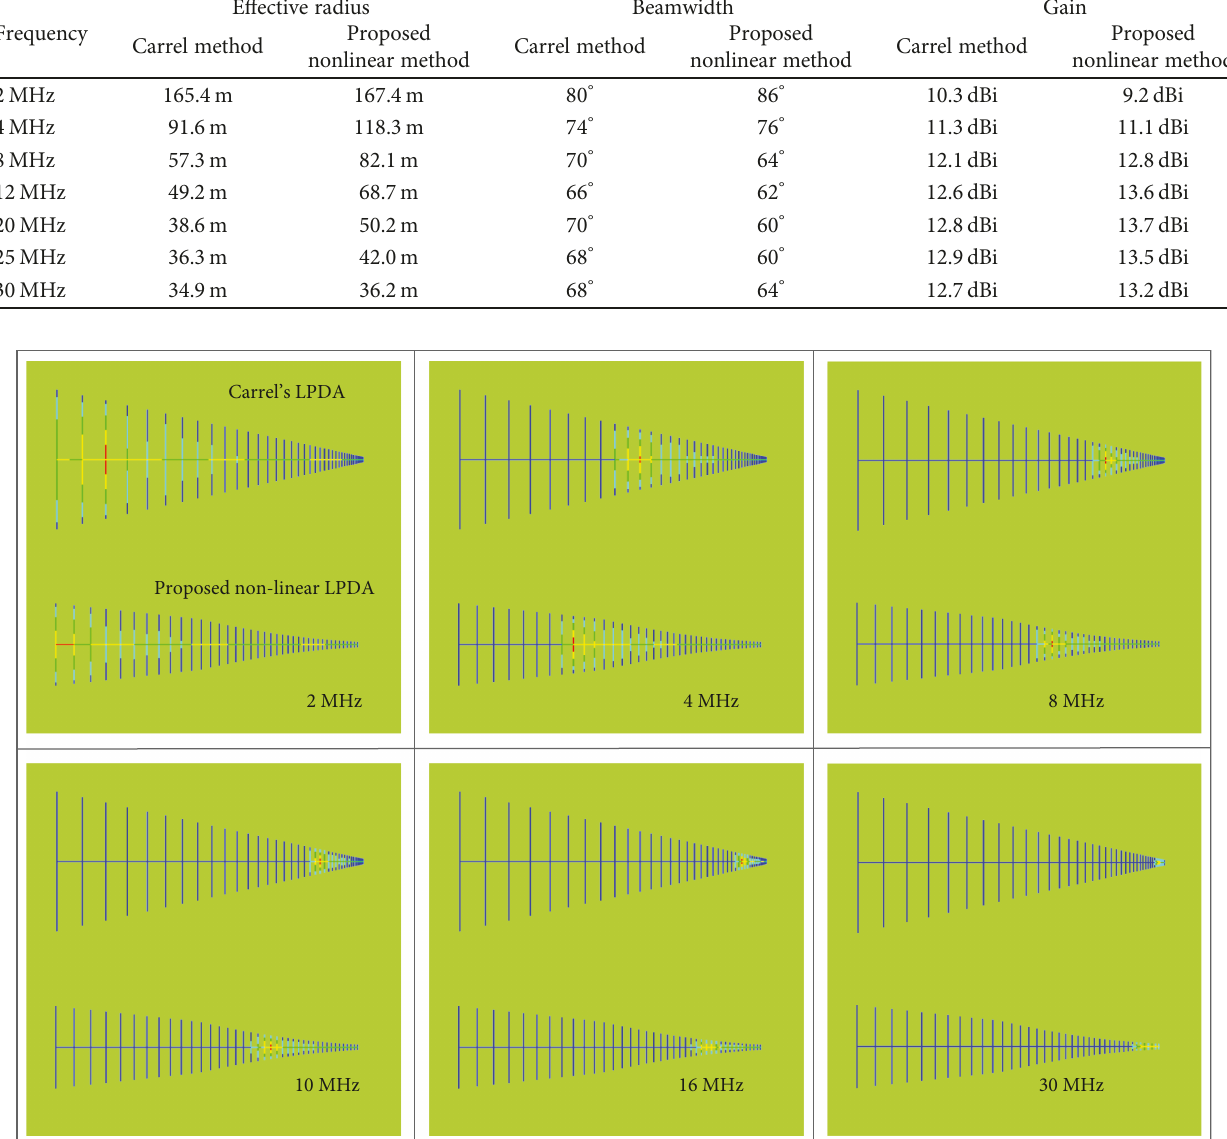
Figure 8: Comparison of the current distribution between the Carrel antenna and proposed LPDA.